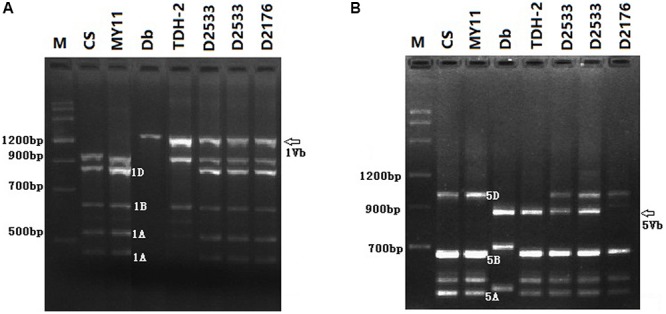
PCR analysis of markers TNAC 1021/TaqI (A) and TNAC1540/HaeIII (B) to the test lines. CS- wheat “Chinese Spring”; MY11- wheat parent; Db- D. breviaristatum; TDH-2- wheat—D. breviaristatum partial amphiploid; D2533- 1VbL.5VbL translocation; D2176- 1Vb substitution. The arrows indicate the D. breviaristatum specific bands.